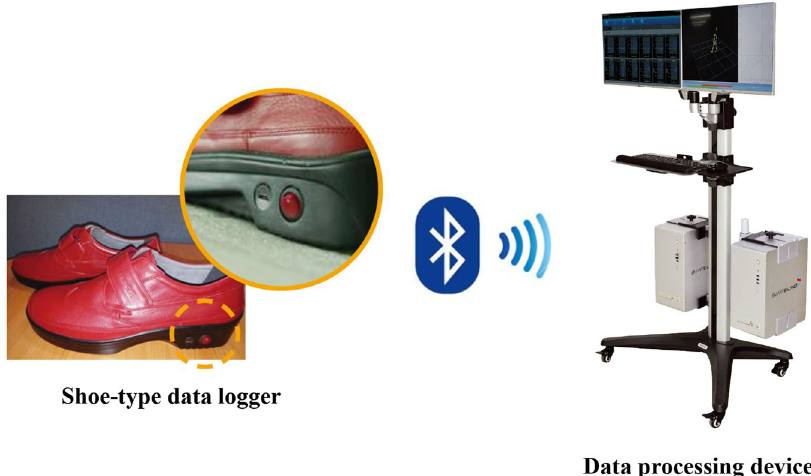
Fig. 1 Inertial sensors are mounted on the shoes. Shoe-type data logger can record gait data continuously during walking. The collected gait data is transferred to the data processing device via Bluetooth